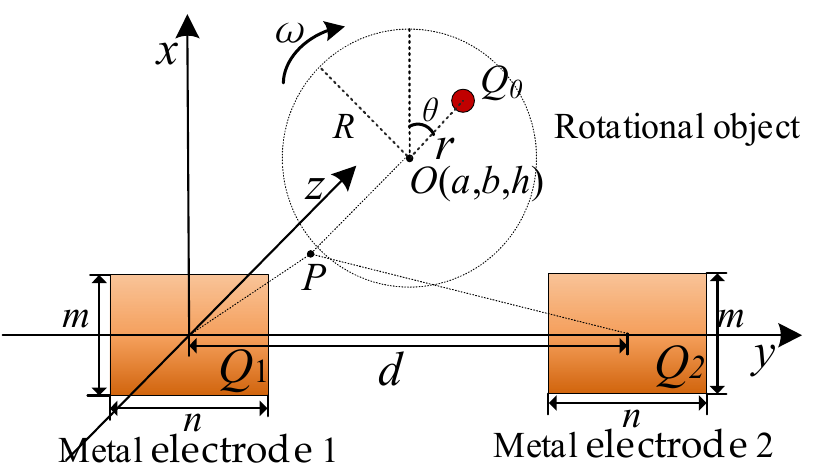
Figure 5. The detection model of rotor direction identification based on two detection electrodes.